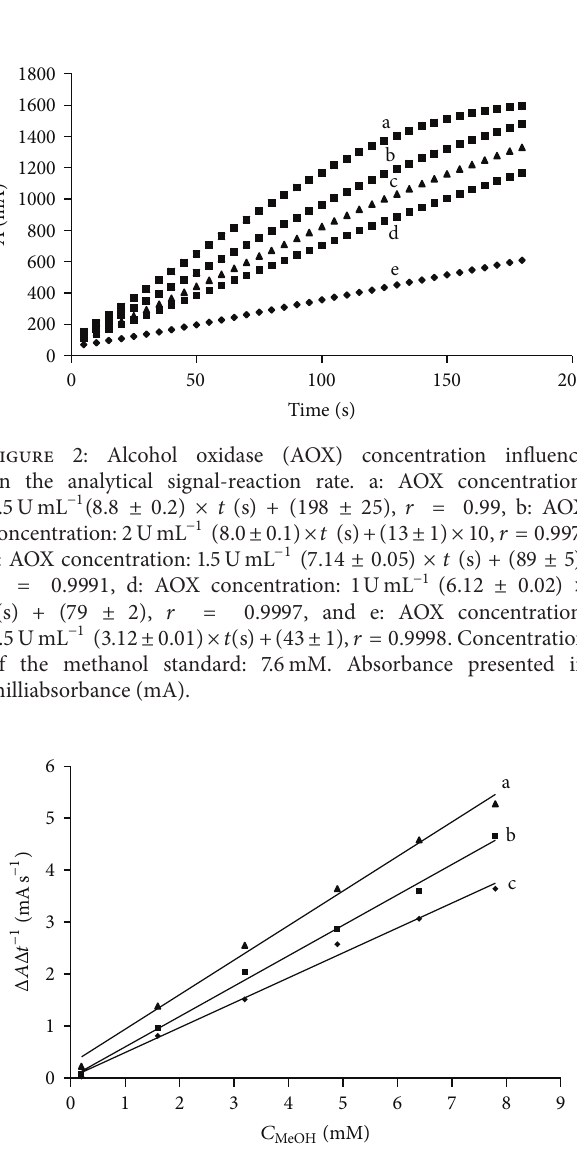
Figure 3: Calibration data obtained at different temperatures. a: 30 ∘ C Δ𝐴Δ𝑡 −1 ( mAs −1 ) = (0.66 ± 0.0.03) × 𝐶 ( mM ) + (0.3 ± 0.1) , 𝑟 = 0.997 , b: 25 ∘ C Δ𝐴Δ𝑡 −1 ( mAs −1 ) = (0.58 ± 0.02) × 𝐶 ( mM ) + (0.01 ± 0.09) , 𝑟 = 0.998 , and c: 20 ∘ C Δ𝐴Δ𝑡 −1 ( mAs −1 ) = (0.48 ± 0.02) × 𝐶 ( mM ) + (0.01 ± 0.01) , 𝑟 = 0.997 .